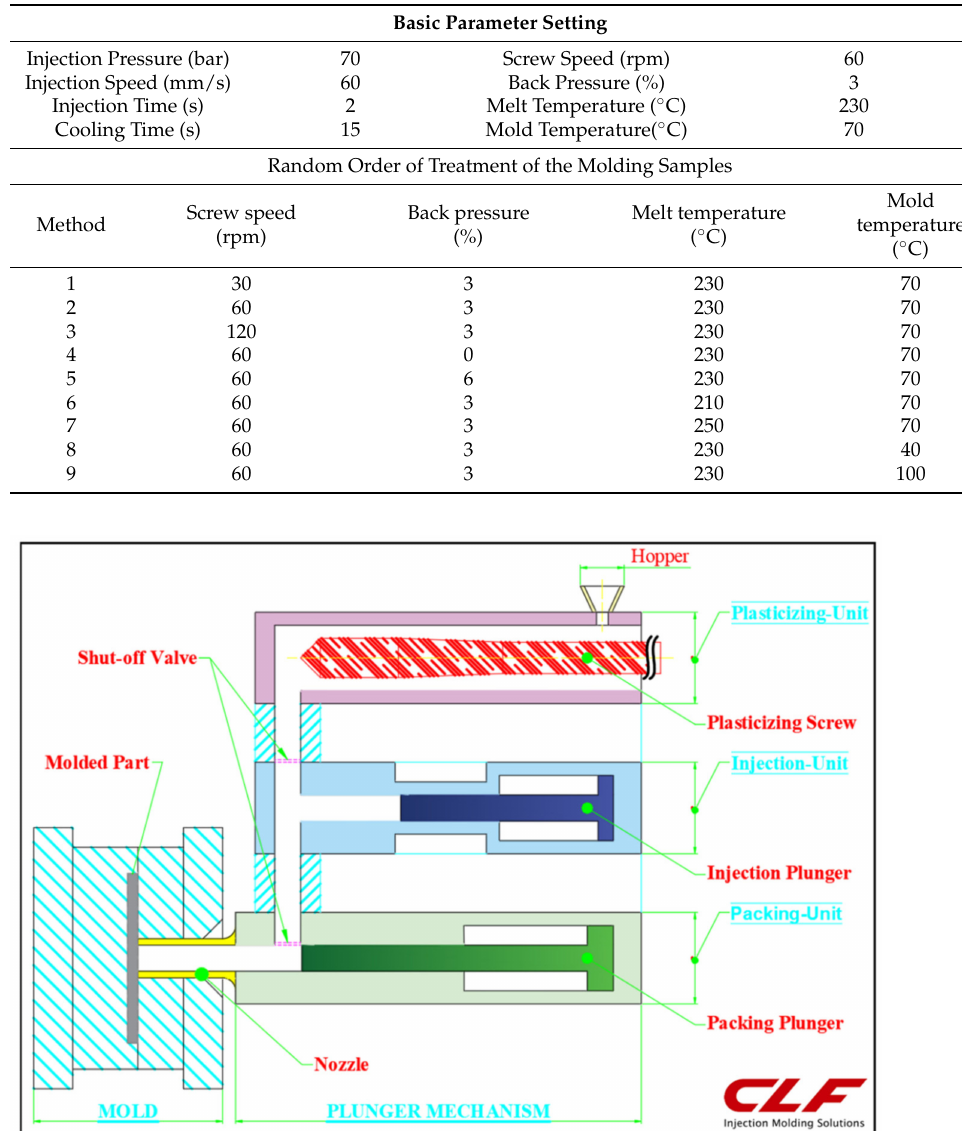
Figure 2. Diagram of the jointly developed ultra-long fiber injection machine with a special three stage plunger and low breaking fiber